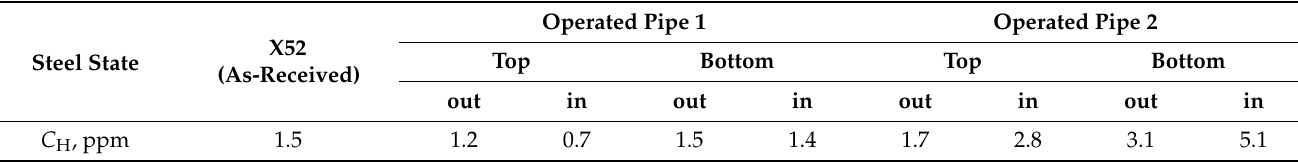
Table 5. Concentration of hydrogen C H in the X52 pipeline steel in the as-received state and after 30-year operation, measured by desorption at 600 ◦ C.